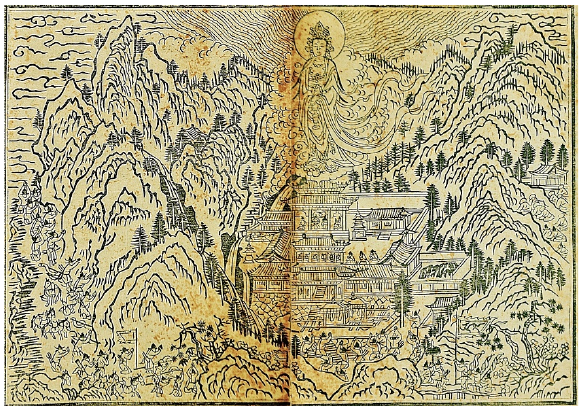
Figure 1. Record of the Manifestation of Avalokitesvara, Joseon dynasty (latter half 15th century), 32.3 × 19.5 cm, Kyujanggak 奎章閣 (Photo by Kyujanggak Institute for Korean Studies).